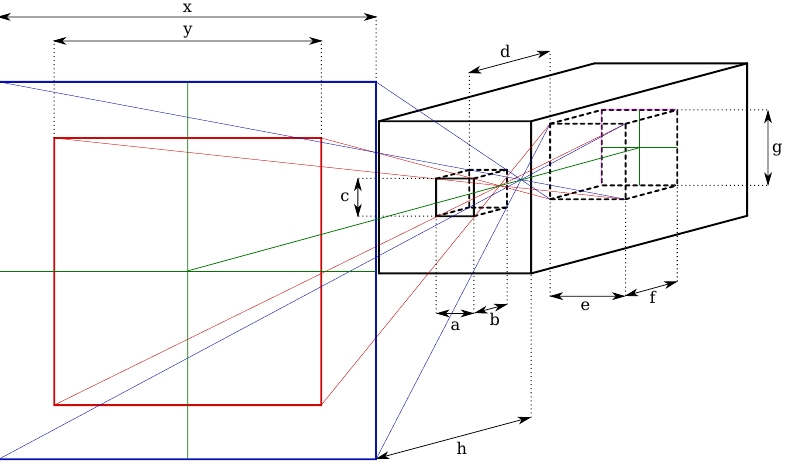
Figure 4. Schematic representation of the detector, showing its CZT detection crystal (cube in the far back with dimensions e × f × g ), collimator with aperture dimensions a × c and thickness b , focal length d , and pixel projection on a surface at a distance h . The green cross represents the reference planes, with the unattenuated pixel area marked in red, and extended (but partially attenuated by the collimator) pixel area is marked in